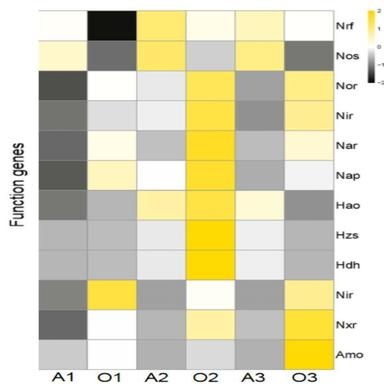
Nitrogen metabolism pathway (a) and functional gene heatmap (b) in different zones.